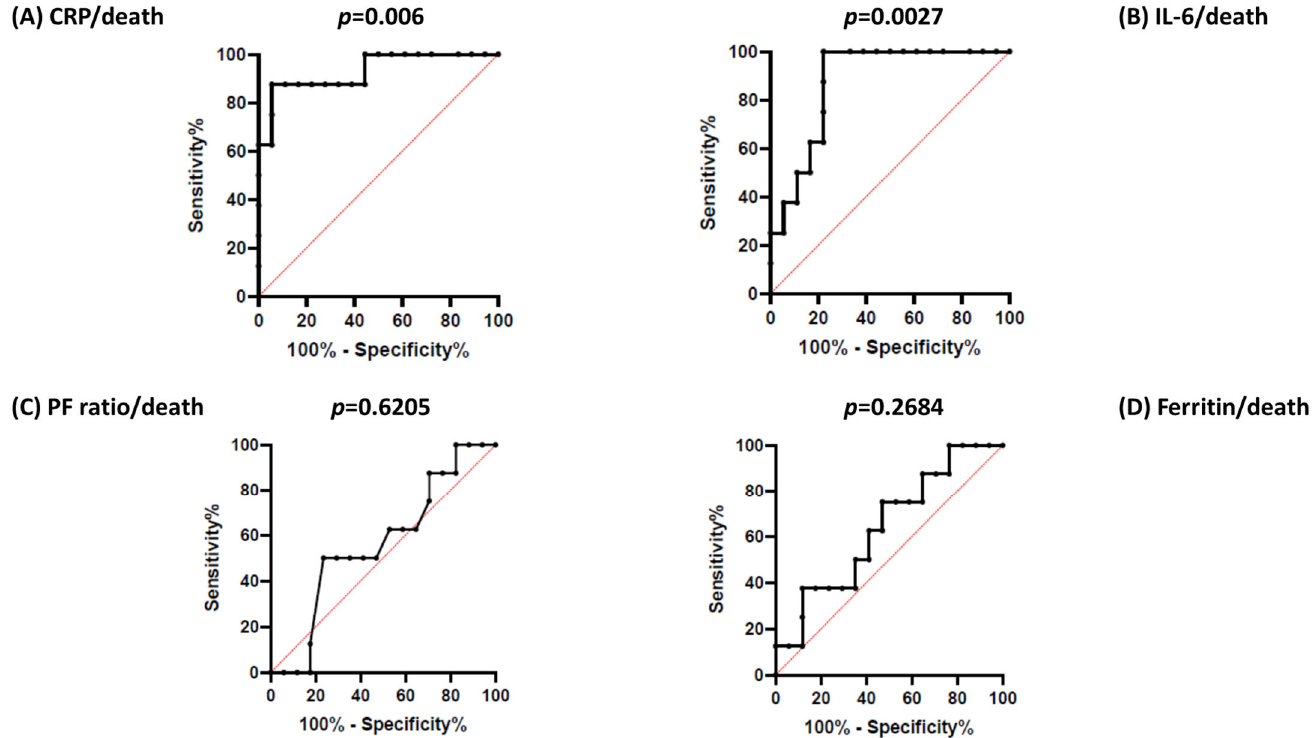
Figure 6. ROC curve analysis for predictors of death: CRP ( A ) and IL ‐ 6 ( B ) at admission resulted in being good predictors of death. No relationship was found between P/F ratio at admission and death ( C ), nor between ferritin and death ( D ).